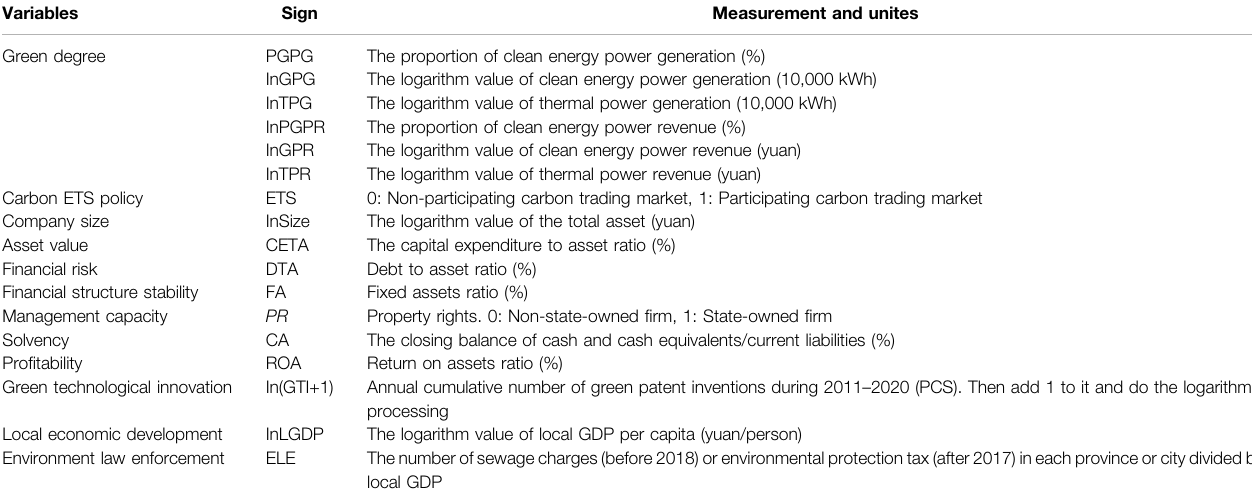
TABLE 1 | The signs and measurements of total variables.